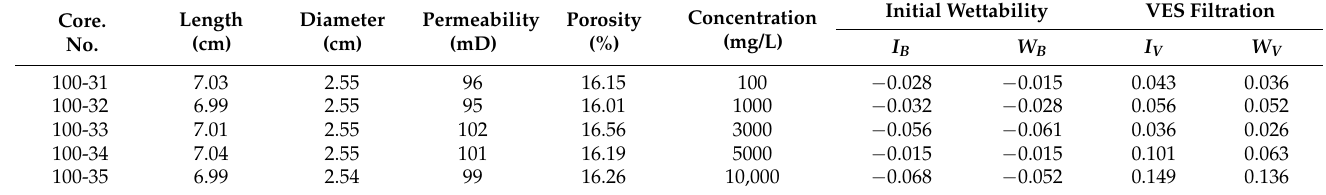
Table 4. Effect of VES concentration on wettability.